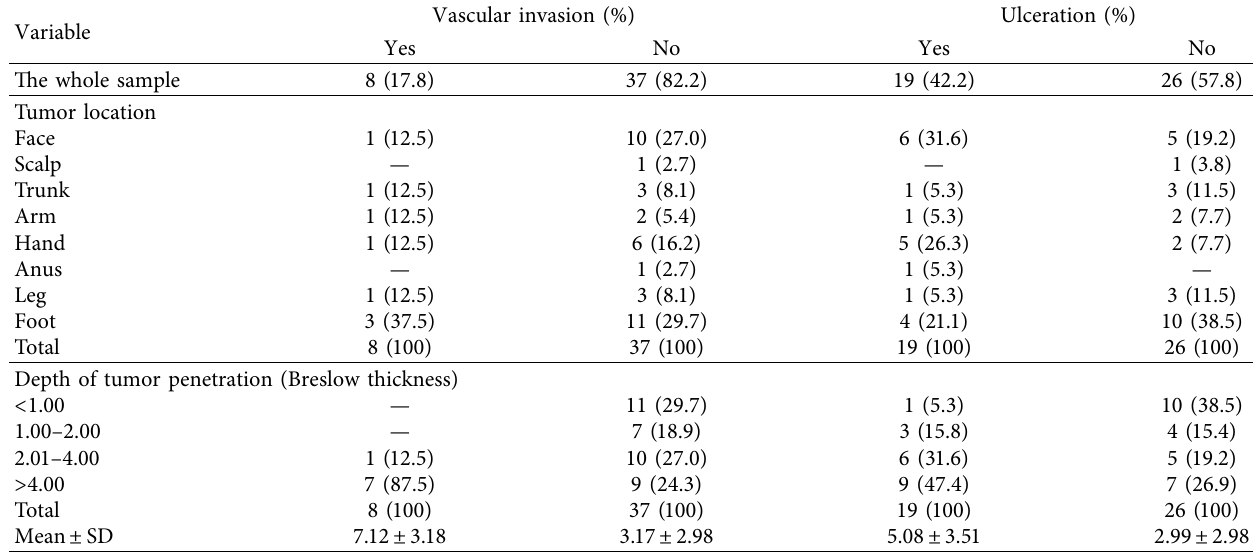
Table 4: The frequency distribution of vascular invasion and ulceration in the samples based on the lesion’s location and depth of tumor